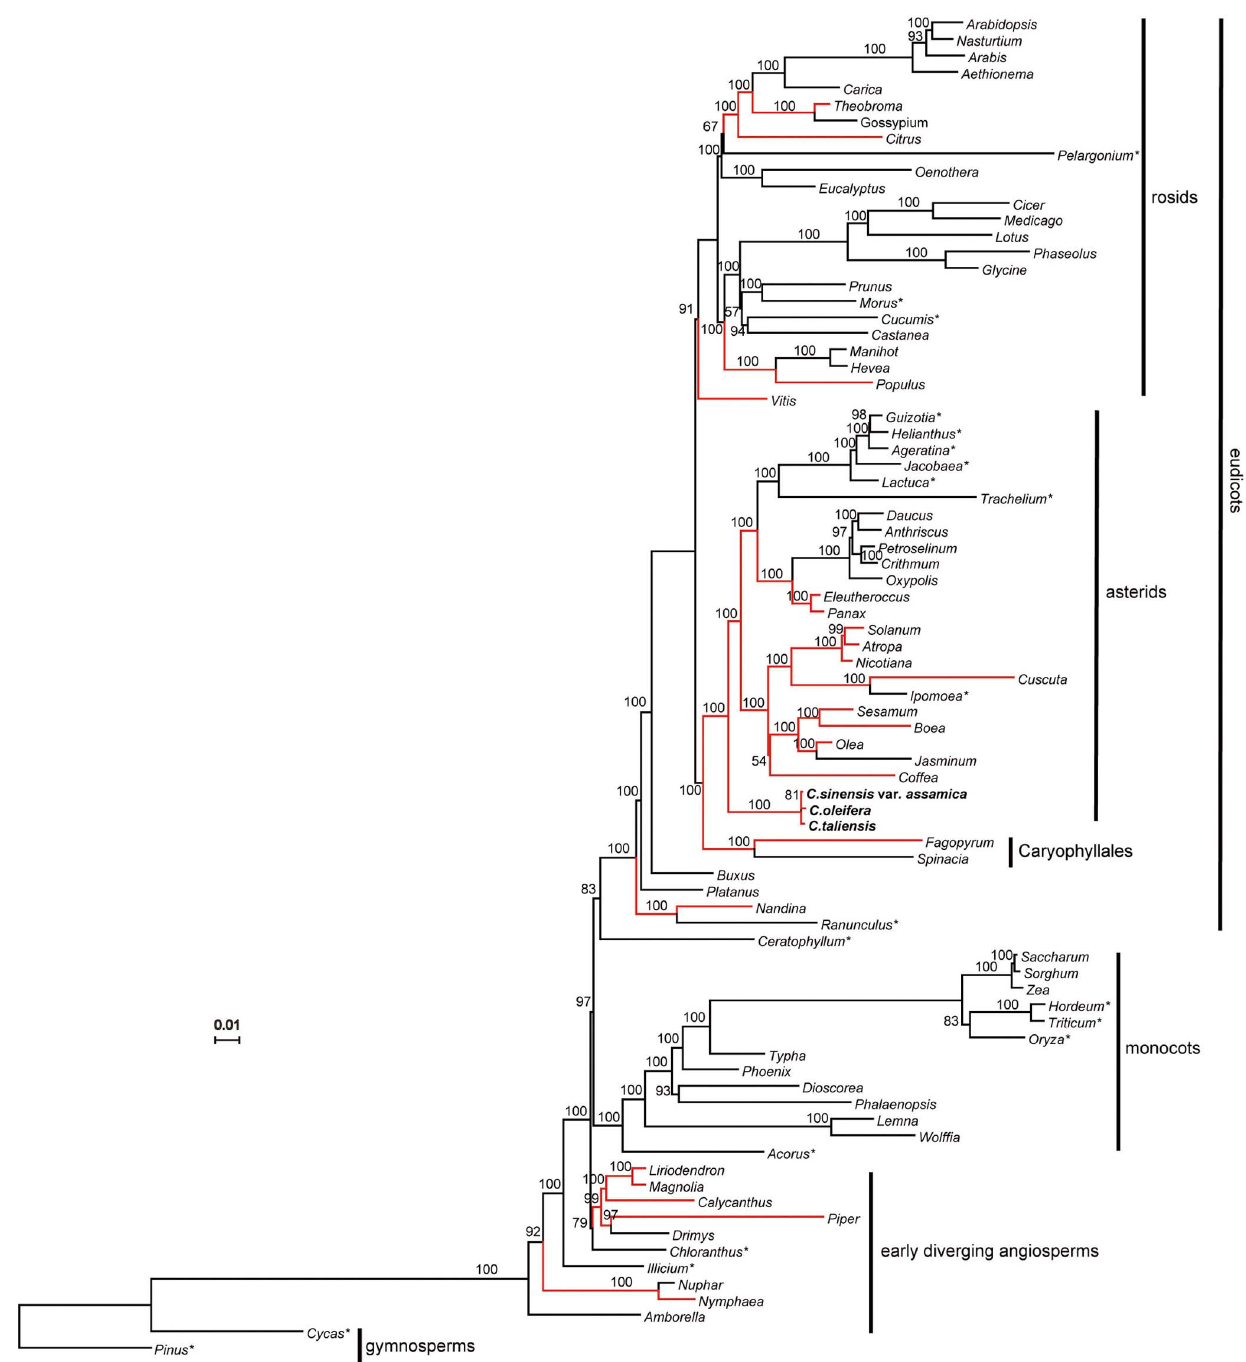
Figure 2. ML phylogram of the angiosperms. The tree has a –lnL=938438.26. Numbers at the nodes are ML bootstrap support values. Three Camellia chloroplast genomes reported here are highlighted in bold. The red branches indicate that intact ycf15 gene is present in related species and asterisks on the top right corner of the species indicate putative losses of ycf15 gene. Scale bar indicates the increment of 0.01 substitutions per site.